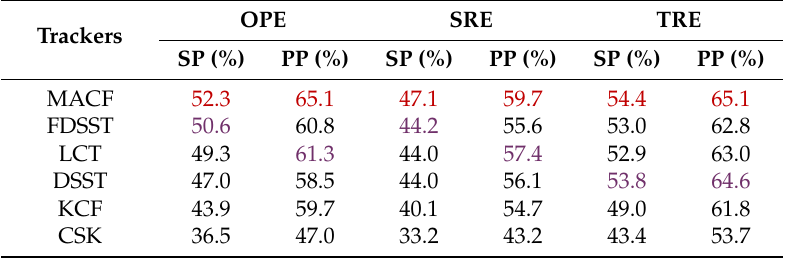
Table 2. The Success Polts (SP) and Precision Plots (PP) of One Pass Evaluation (OPE) for the proposed MACF and the other 7 top trackers on the OTB-50 dataset. The best results are highlighted in red and the second results are highlighted in blue.